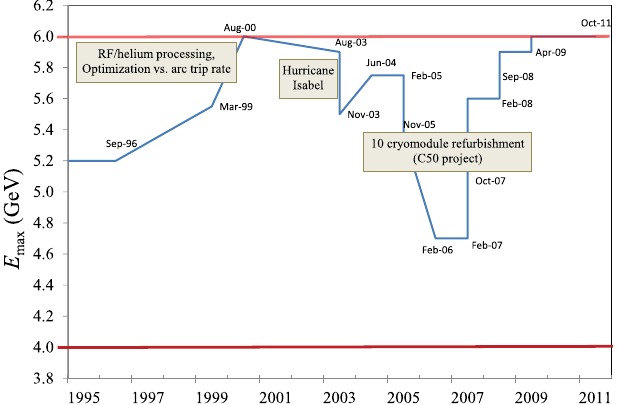
FIG. 21. CEBAF maximum beam energy evolution prior to and during the C50